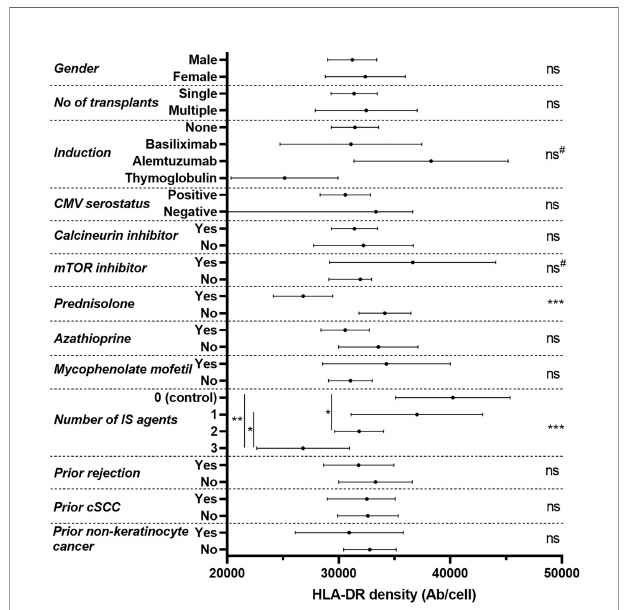
FIGURE 2 | Forest plot of discrete variables at recruitment and their univariable in fl uence upon mHLA-DRd in renal transplant recipients. Densities are recorded as mean and 95% con fi dence interval, with p values assessed by two-tailed independent t-test or analysis of variance with post-hoc Tukey testing. ‘ ns ’ not signi fi cant; * p<0.05; **p<0.01; ***p<0.001 across all groups (ANOVA or t-test, indicated on right, with post-hoc testing, where appropriate, indicated on left with the vertical line indicating comparison groups). #